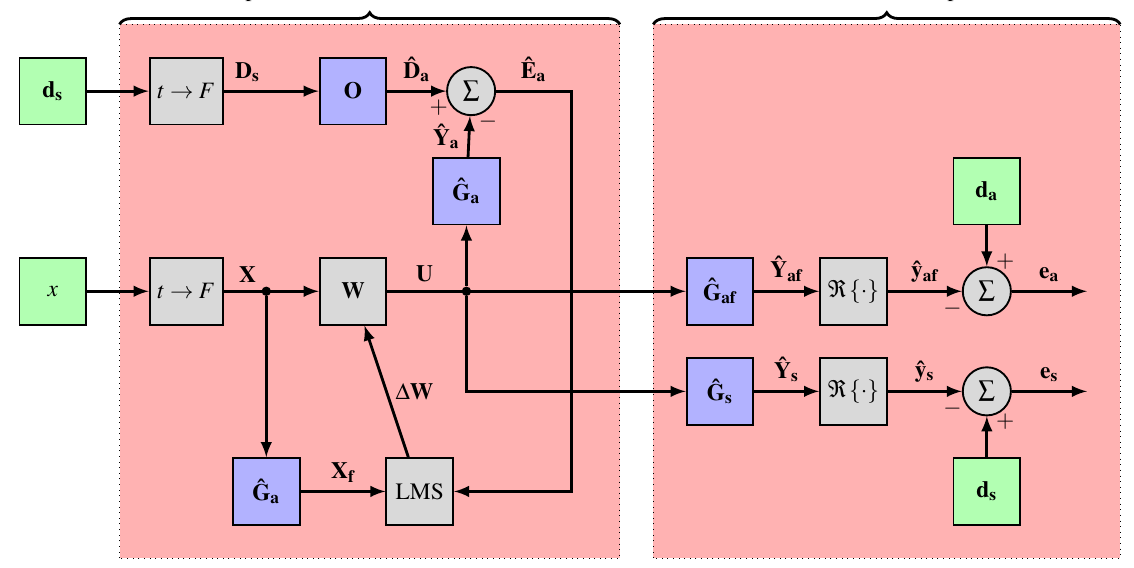
Figure 4. Block diagram of the adaptive controller with observer filter and performance